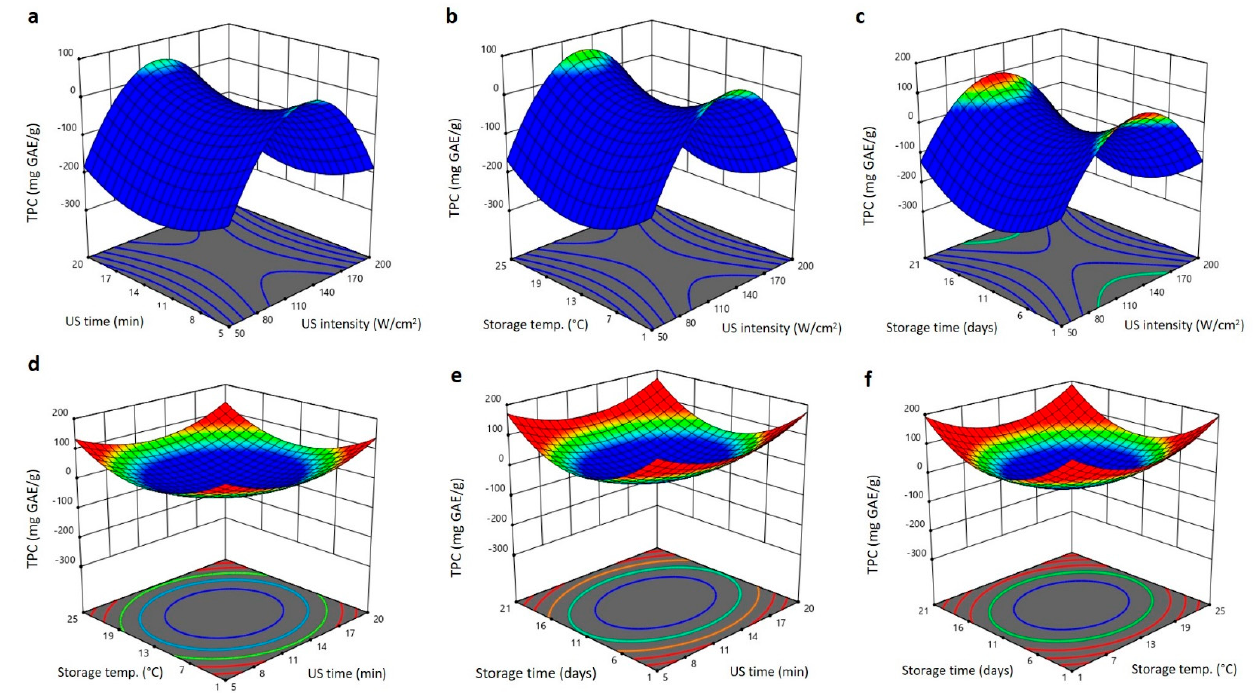
Figure 6. Response surface plots of total phenolic content (TPC) of Barhi dates as a function of US time and US intensity ( a ), storage temperature and US intensity ( b ), storage time and US intensity ( c ), storage temperature and US time ( d ), storage time and US time ( e ), and storage time and storage temperature ( f ).